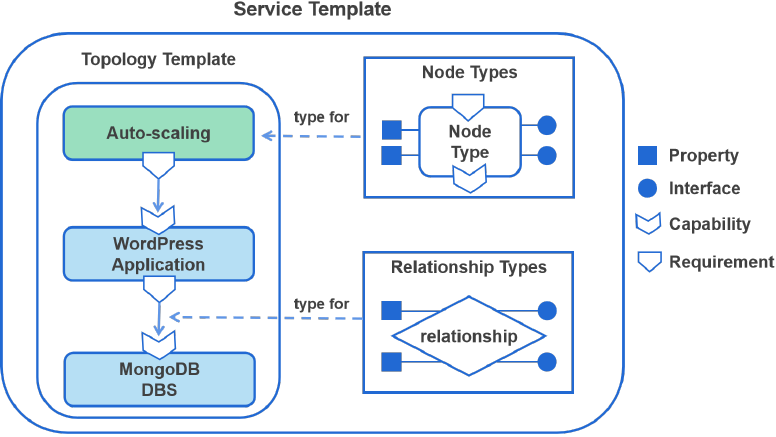
Figure 1. TOSCA definition for a sample application.